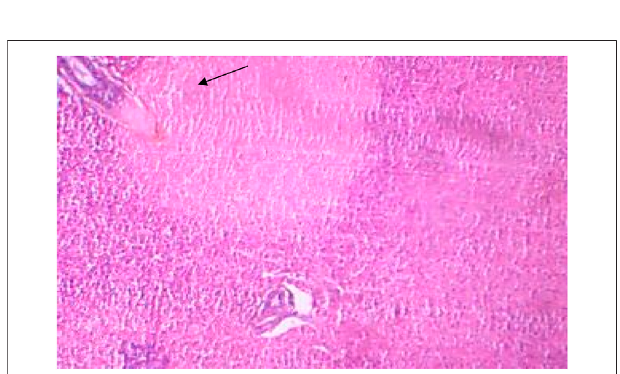
FIGURE 5 | Treated liver showing